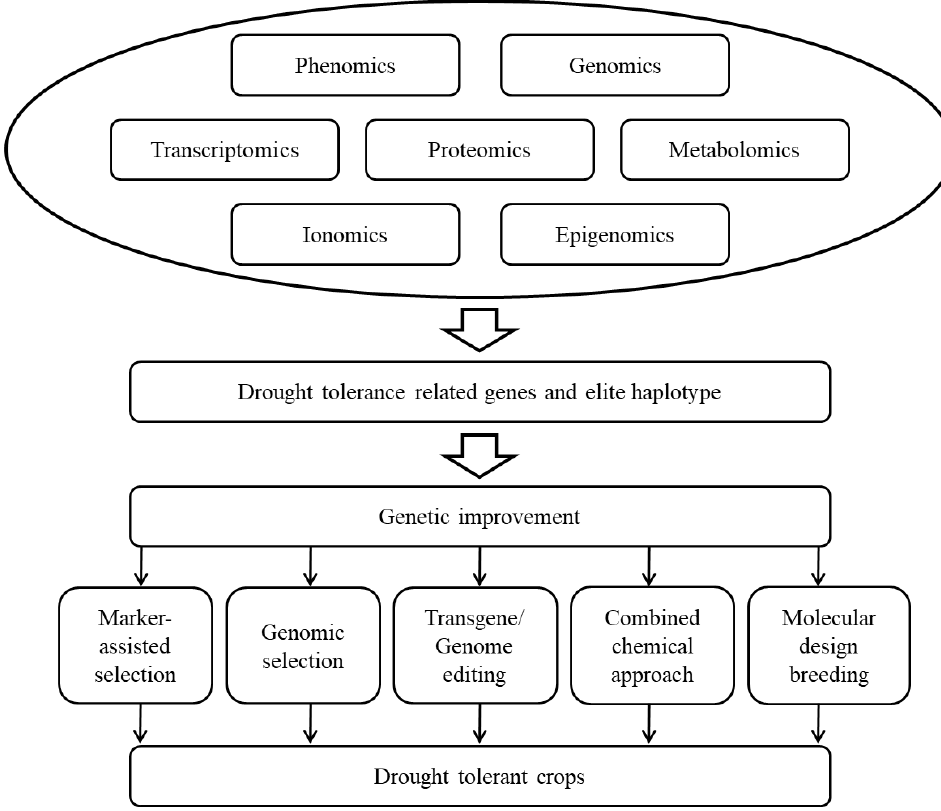
Figure 1. Approaches of breeding for drought tolerance in crops.